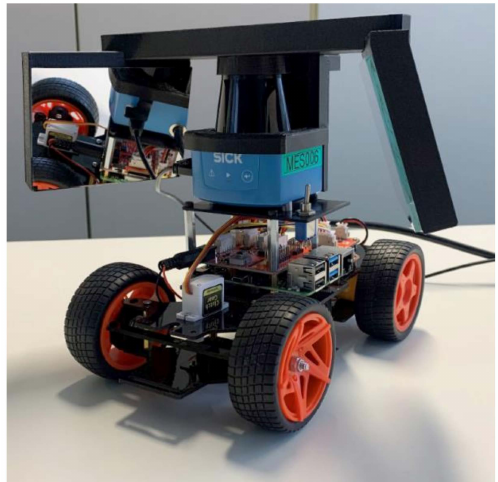
Figure 1. Prototype vehicle. As the construction base, the “PiCar” can be seen, consisting of four rubber tires, a servomotor for steering the two front wheels, and a “Raspberry Pi” computer for data processing and navigation. A mechanical platform holds the 2D-Lidar sensor (blue) on top of the computer board. Attached to the Lidar sensor is a larger mechanical part (black), which holds the two plane glass mirrors at either side of the Lidar sensor. Lithium polymer batteries and the power supply board are not visible as they are attached underneath the vehicle.